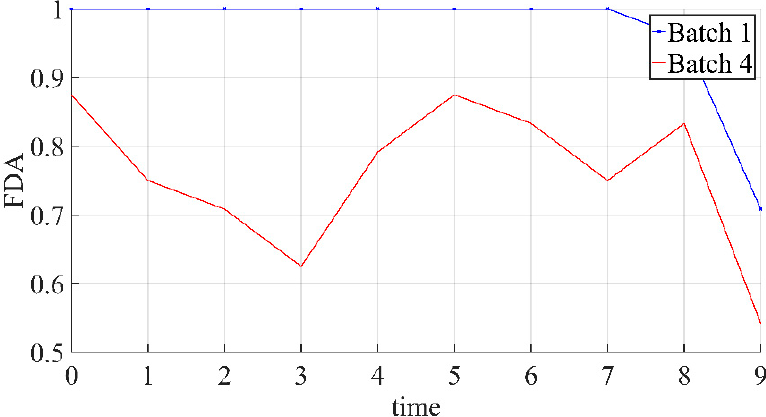
Figure 7. The relationship between the average diagnosis rate under different normal conditions in each time window.